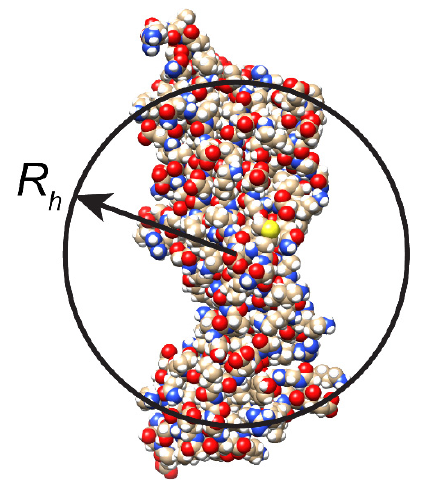
Figure 1. Schematic representation of effective hydrodynamic radius R h of non-spherical protein molecule.